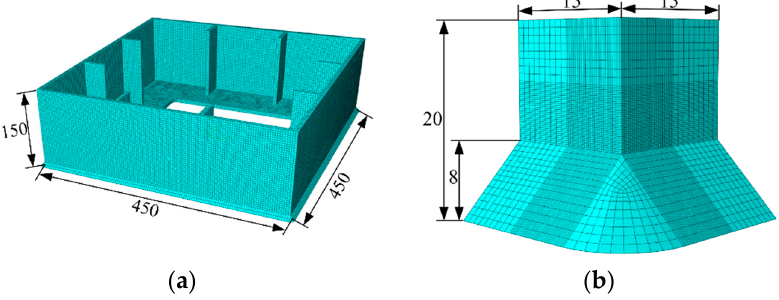
Figure 4. Mesh and submodels: ( a ) Sub-model I (unit: mm); ( b ) sub-model II (unit: mm). Table 3. Summary of meshing information.